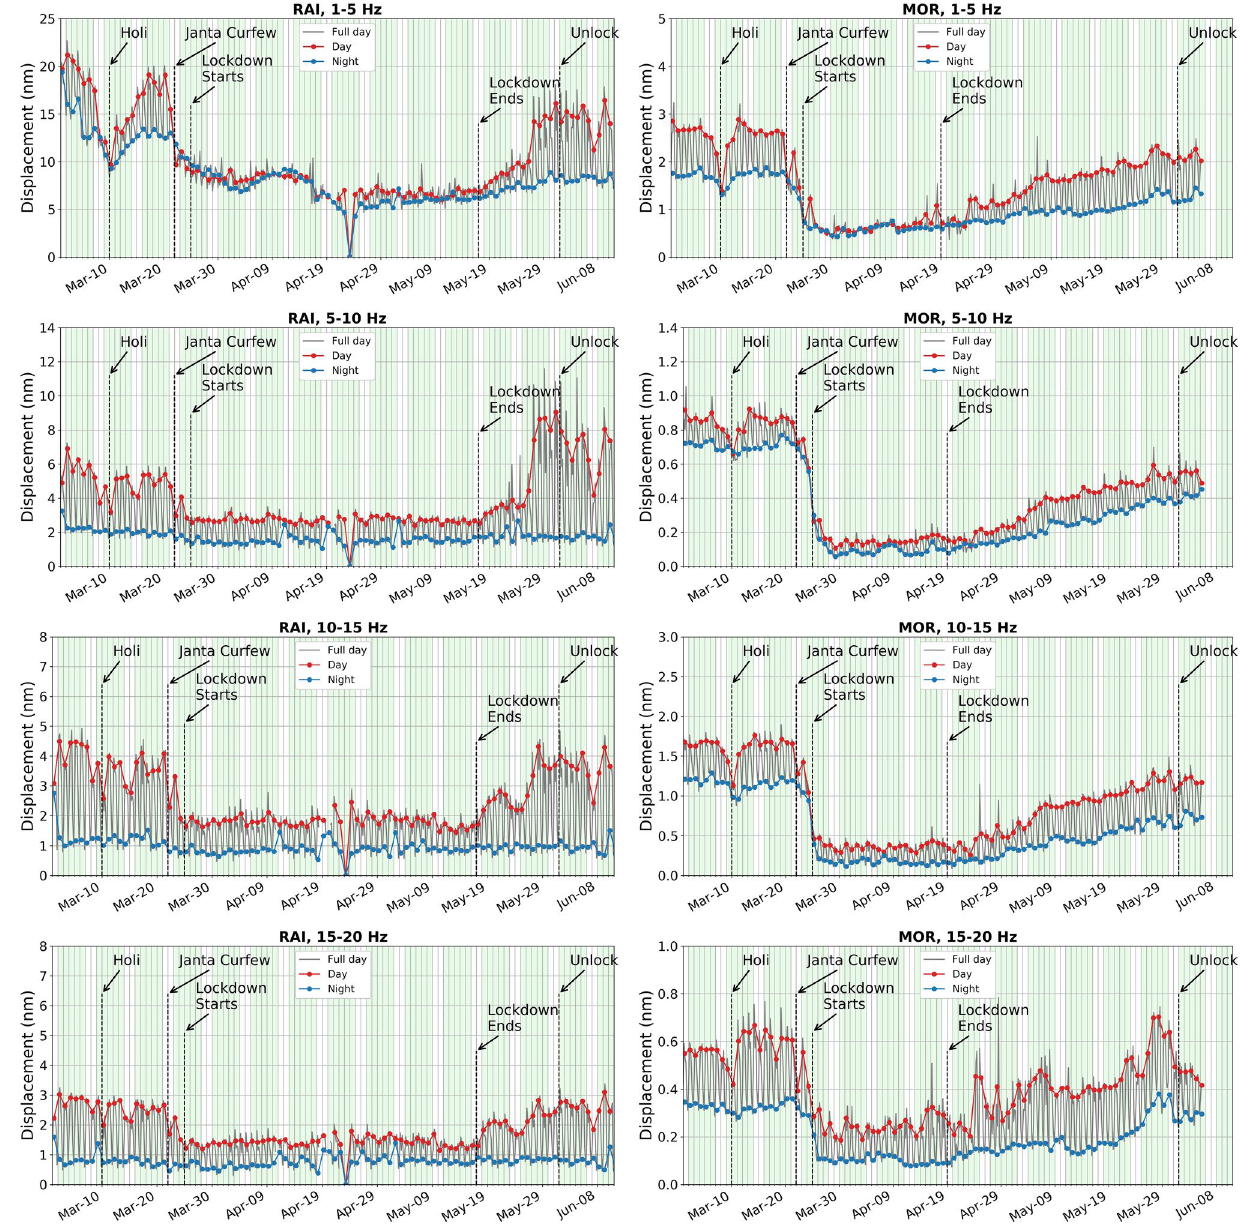
Figure 4. Day wise ground displacement variation in terms of median d rms for the pre-, co- and post-lockdown periods at stations MOR and RAI in different high frequency ranges (1–5 Hz, 5–10 Hz, 10–15 Hz and 15–20 Hz) between 1 and 20 Hz. The variation in ground displacement during daytime and nighttime is also shown. The complete lockdown period, beginning of Unlock, Janta Curfew and extended holiday during Holi (Indian Festival) are also marked. Subsurface geology and other local anthropogenic conditions are mentioned in Table On analyzing the seismic background noise through PSD and d rms median values in different frequency ranges between 1 and 20 Hz, the effect of lockdown is prominently visible in the 5–15 Hz range, with minimal interference from local earthquakes and other environmental factors 3, 10, 22 . Besides this, in the frequency range of 5–15 Hz, the diurnal variation is quite evident and follows the same pattern during the pre- and co-lockdown periods, with lesser d rms amplitude recorded in the latter (Fig. 5). Hence, in our case, we have considered the 5–15 Hz range to discuss diurnal and hourly variations at all the stations (Figs. 5, 6 and 7). Moreover, we have removed the records of local earthquakes from the datasets at all the stations. The hourly plots represent the median of d rms on the corresponding days (Fig. 6). For example, the median value of all Mondays before the lock- down period is considered for the pre-lockdown plot and the median of all Mondays which fall during complete lockdown represent the co-lockdown plot. In Figs. 6 and 7 the results for specific stations (RAI, MOR, DWK and UKI) are shown, where major or some changes are observed between pre- and co-lockdown periods. Similar plots